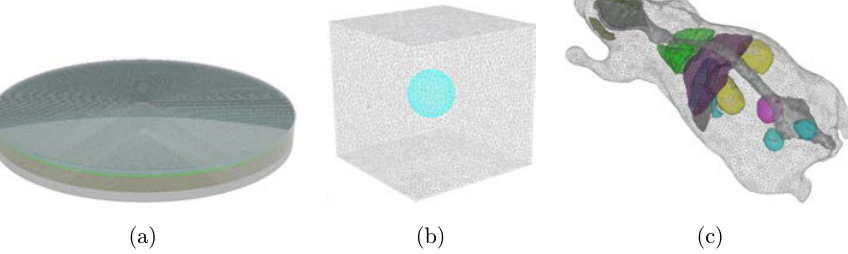
Fig. 2. Structure of the phantoms for the comparisons of MC-based simulation packages. (a) Multilayered tissues, (b) Regularly shaped tissue, and (c) Digital